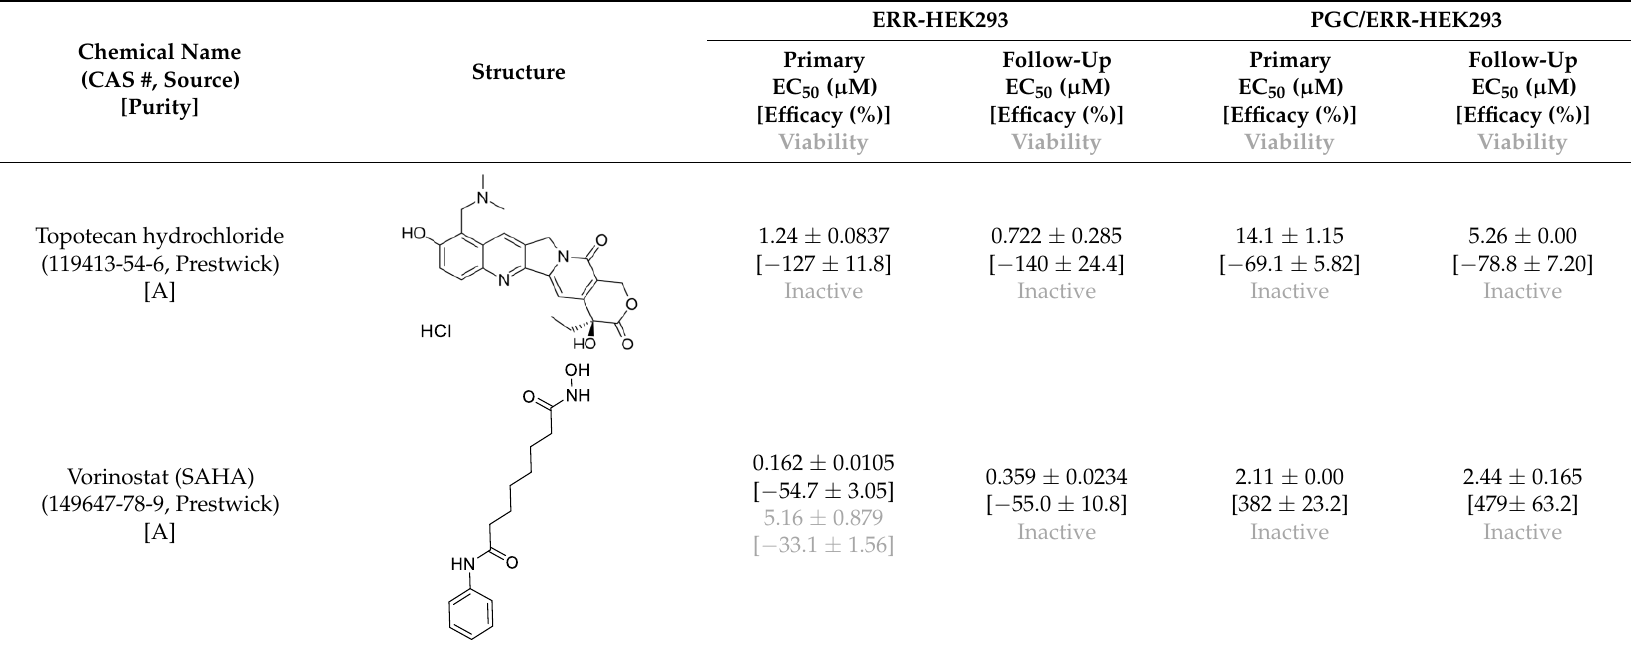
Table 2. Pesticide compound qHTS primary and confirmation ERR and PGC/ERR EC 50 and efficacy